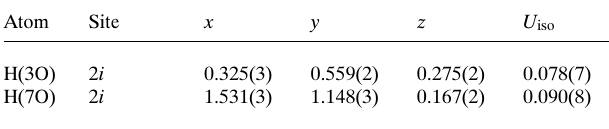
Table 2. Atomic coordinates and displacement parameters (in Å 2 ) .